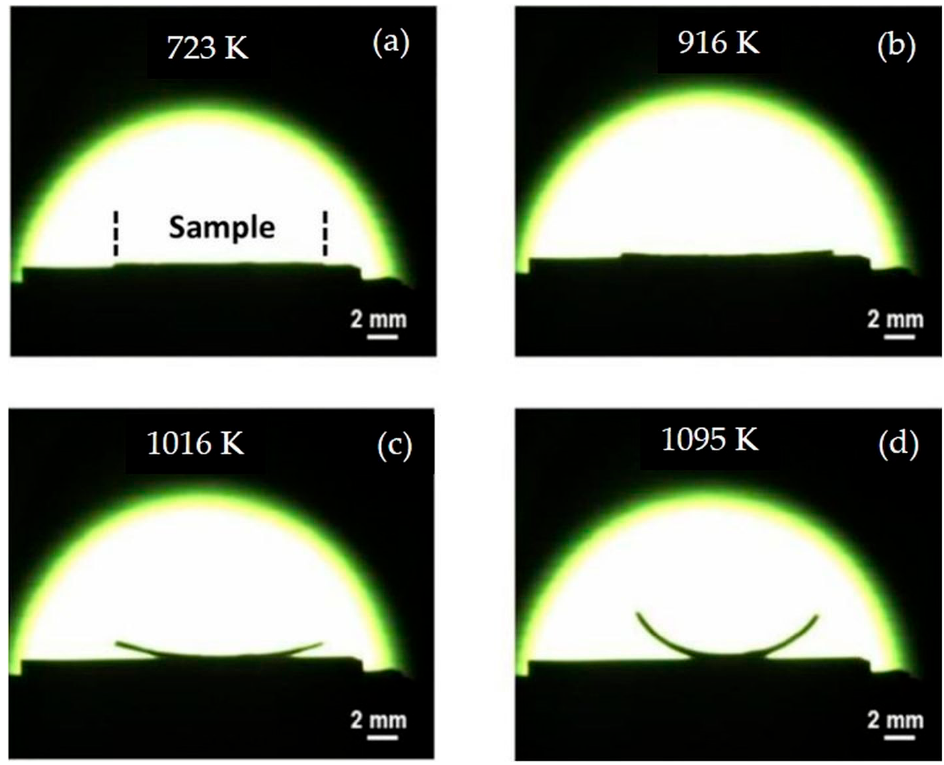
Figure 9. Camber measurements of the bilayer at ( a ) 723 K, ( b ) 916 K, ( c ) 1016 K, and ( d ) 1095